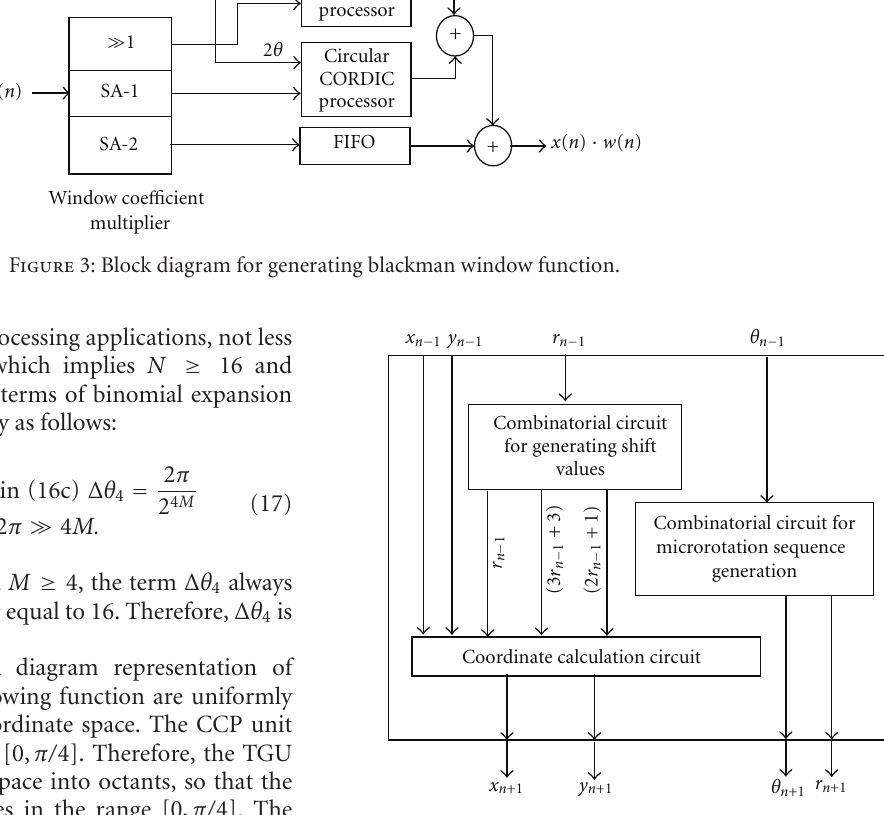
Figure 4: Pipeline stage of new redesigned CORDIC